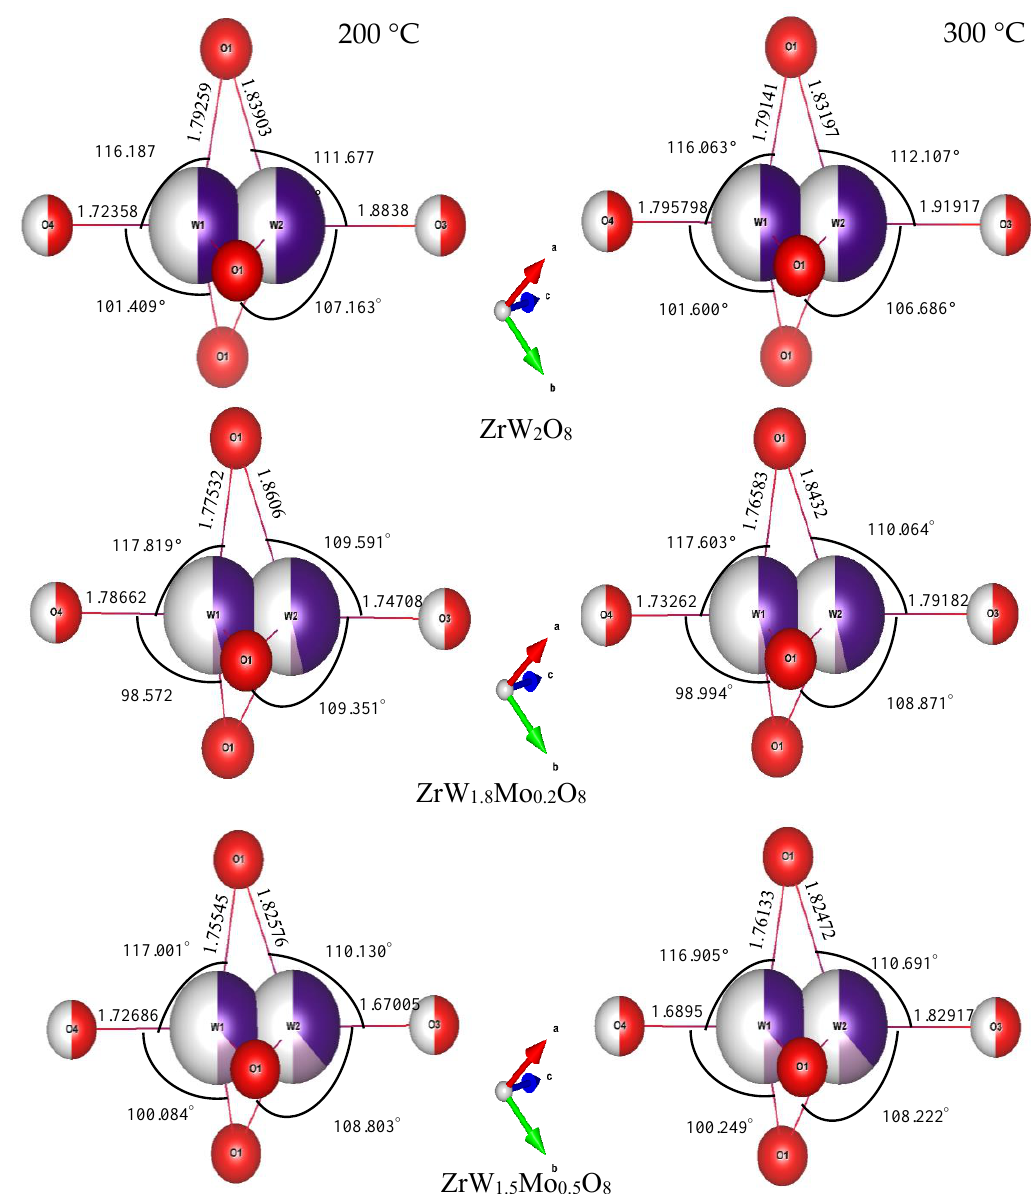
Figure 11. Bond lengths and bond angles of W(Mo) 2 O 8 polyhedra in ZrW 2− x Mo x O 8 compounds. A noteworthy finding is that the bond lengths of W(Mo)1 – O4 and W(Mo)2 – O3 not only varied greatly with the temperature (from 200 °C to 300 °C), but also varied greatly with the Mo content. This may be related to the one-coordination of O 3 and O 4 atoms. Different W(Mo) – O bond lengths in different directions indicate stronger distortion in the polyhedra. Two factors necessary for distortion of a polyhedron are quadratic elongation (λ) and bond angle variance (σ 2 ) [27]. The variance values of the distortion constants λ and σ 2 between 200 °C and 300 °C are shown in Figure 12. We can see that the ZrO 6 octahedron is basically in an undistorted state, which is attributed to all bond lengths Zr – O1 being equal and all bond angles being close to 90°. In the W(Mo) 2 O 8 polyhedron, the degree of distortion increased greatly with the temperature because of the instability of the one-coordinate oxygen atoms. The degree of distortion gradually decreased with increasing Mo content, resulting in a decrease in the NTE coefficient.